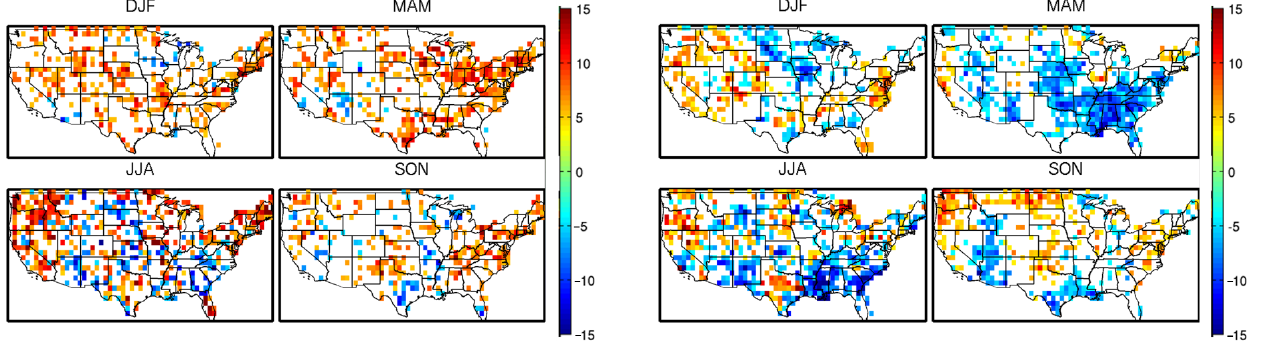
Figure 13. Same as in Fig. 12, but for T mean